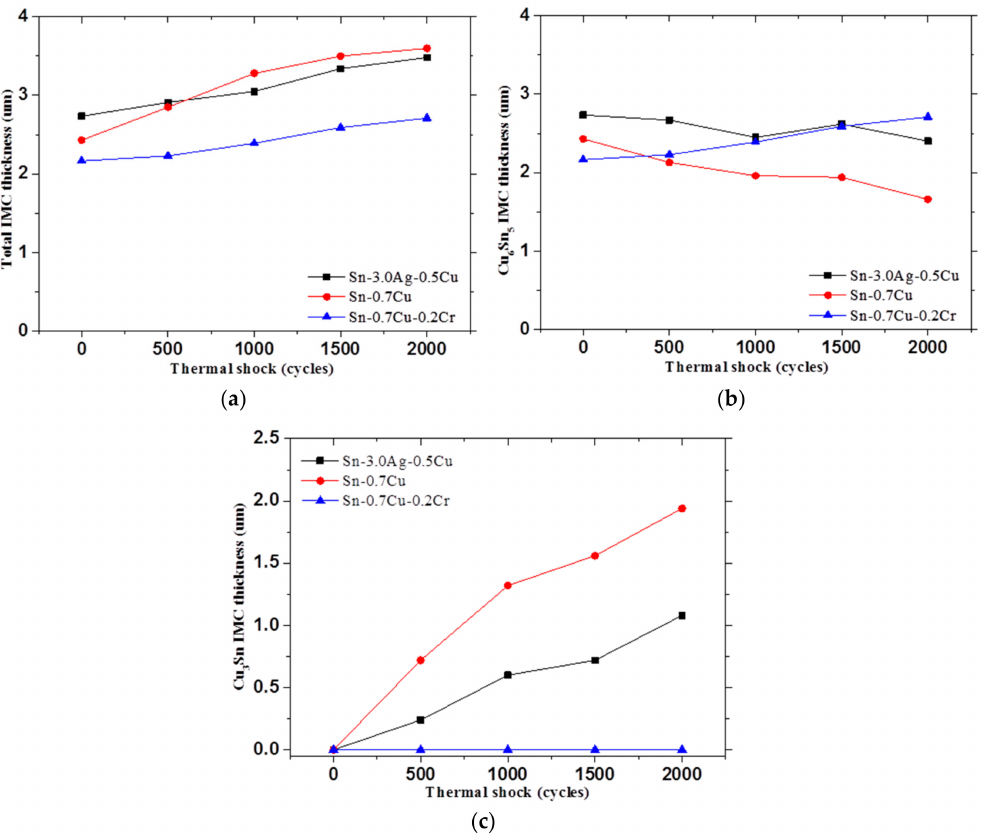
Figure 4. Plot of the thickness of IMC versus thermal shock cycles: ( a ) Total IMC thickness, ( b ) Cu 6 Sn 5 IMC thickness, ( c ) Cu 3 Sn IMC thickness.